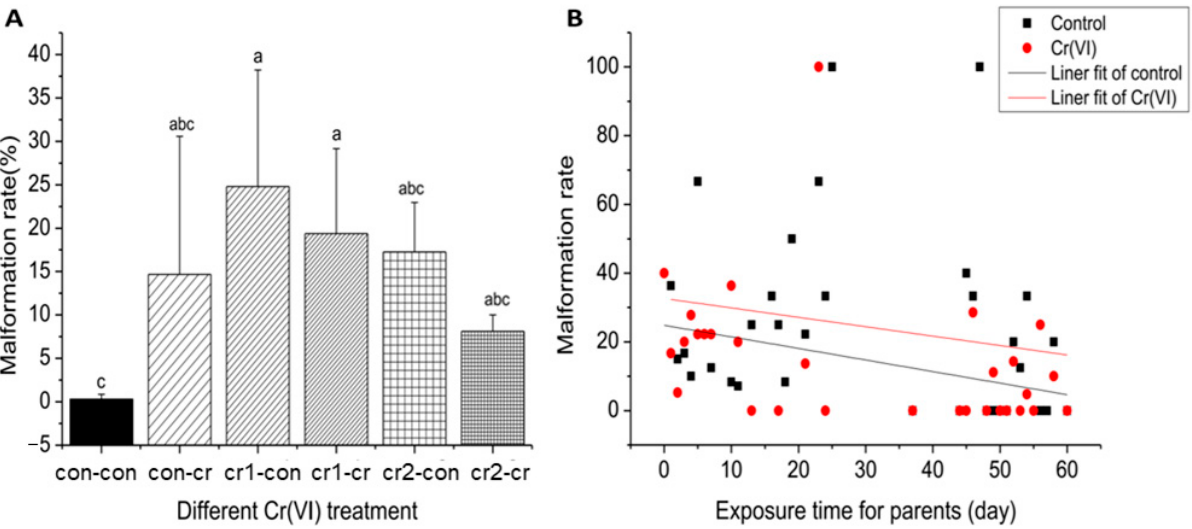
Figure 4. The malformation rate after long-term Cr(VI) exposure ( A ) the malformation rate of offspring under different Cr(VI) treatment, different lower case means the significant differences among different treatment ( p ≤ 0.05); ( B ) daily malformation rate under different Cr(VI) exposure after parental Cr(VI) exposure, X axis represents parental treatment, and Y axis represents daily malformation rate, the blank line represents offspring in control environment, the red line represents offspring in Cr(VI) environment; the function relationships between exposure time and death rate were y = − 0.3x + 24.8, R 2 = 0.10 (untreated offspring) and y = − 0.2x + 32.6, R 2 = 0.01 (treated offspring). The number of biological samples used for each group is as follow: con-con ( N = 486), con-cr ( N = 81), cr1-con ( N = 145), cr1-cr ( N = 159), cr2-con ( N = 90, cr2-cr ( N = 87).